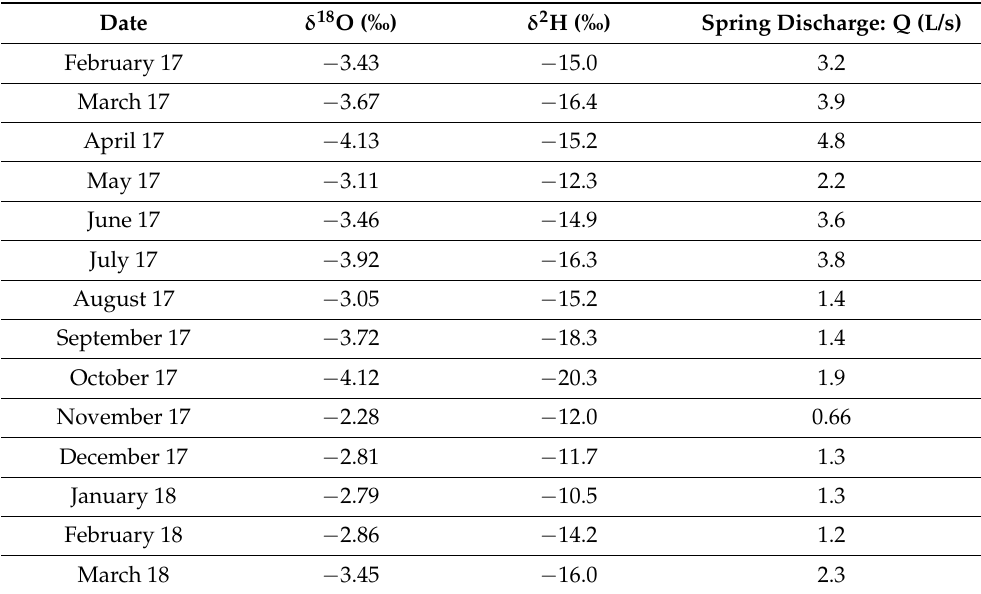
Table 2. The stable isotope and spring discharge data for the Albert Farm spring over the 14 month period.